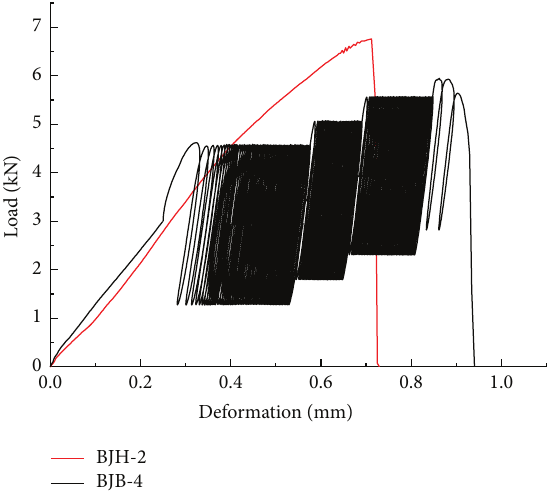
Figure 9: Contrast figure of conventional split and split fatigue.